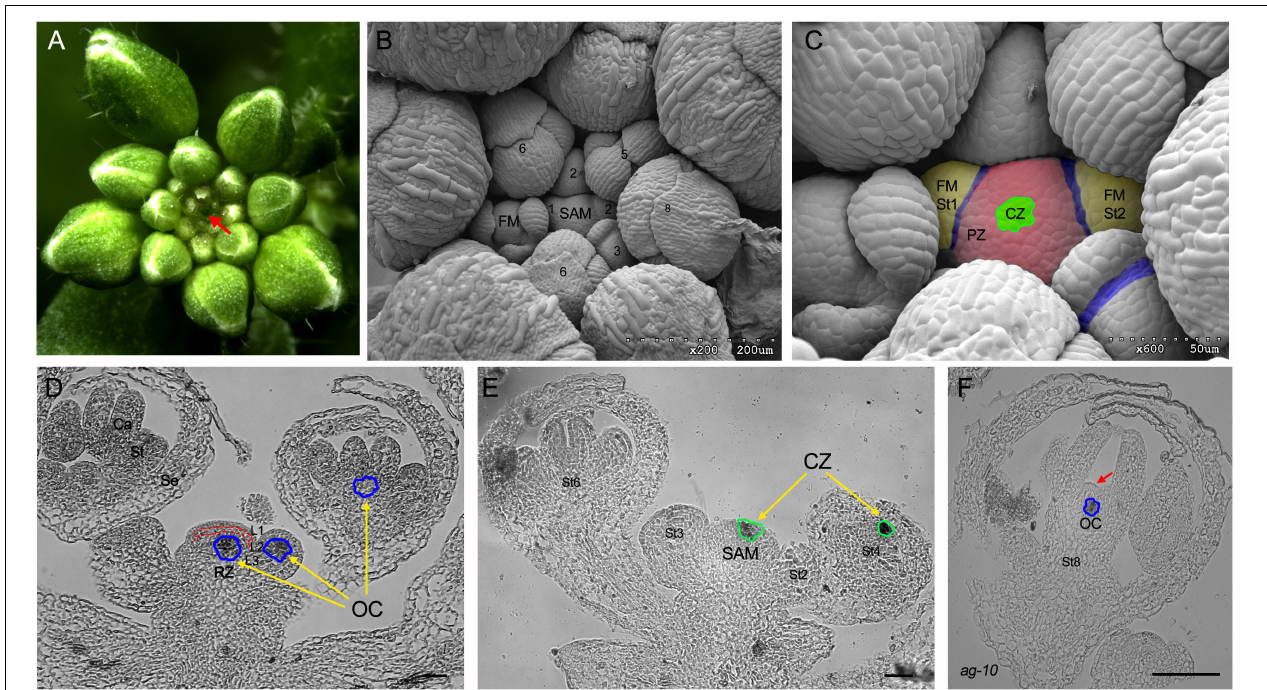
FIGURE 1 | The shoot apical meristem (SAM) and floral meristems (FM) of Arabidopsis. (A) Top view of the inflorescence. The SAM is localized at the center and marked by a red arrow. (B,C) Overhead view of the SAM and FM. Numbers indicate the developmental stage of flower (Smyth et al., 1990). The central zone (CZ) and peripheral zone (PZ) are labeled by green and magenta color, respectively. The FMs are labeled by pale yellow color. The meristem–organ boundaries are marked in blue. (D,E) The longitudinal sections of SAM and FM. The organizing center (OC), in which the WUS is expressed, is marked by the blue cycles. The CZ that is marked by the expression of CLV3 detected by in situ hybridization is labeled by green circles. RZ, rib zone; L1, L1 cell layer; L2, L2 cell layer; Se, sepal; St, stamen; Ca, carpel. (F) In situ assay to show prolonged WUS expression (marked by blue circle) in one indeterminate floral bud at stage 8 of ag-10 , a weak agamous allele, and the indeterminate meristem is marked by a red arrow. (D–F) Scale bar = 50 µ